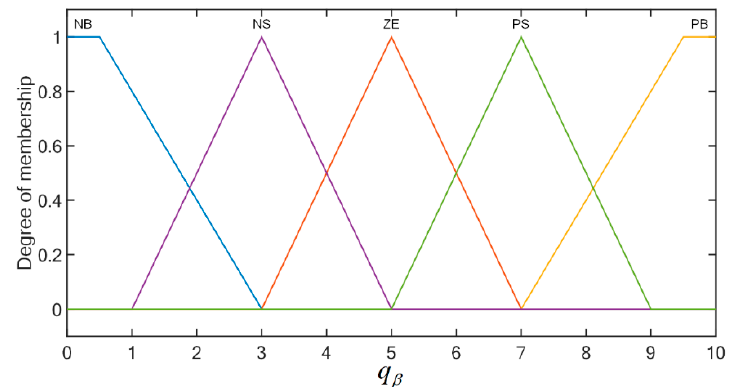
Figure 8. Membership function of 𝑞 (cid:3081) .